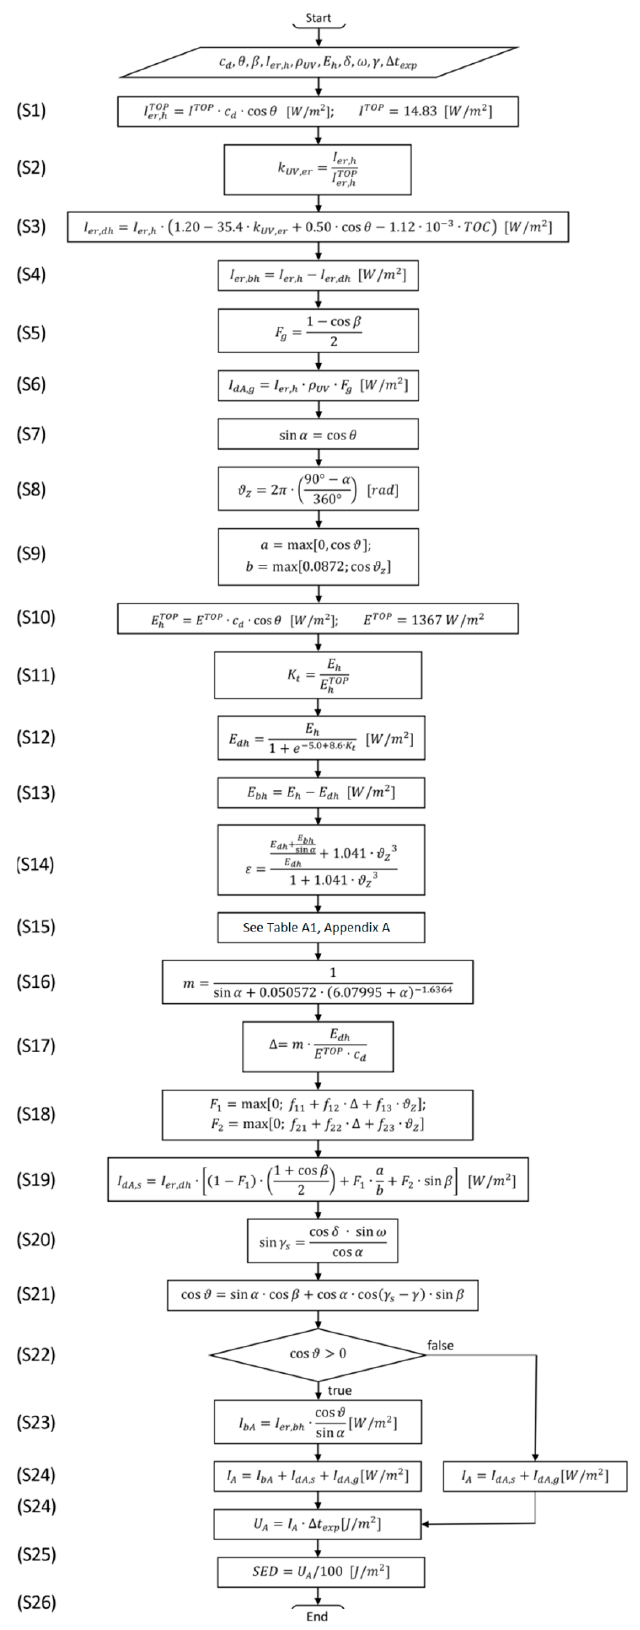
Figure 1. Flow-chart representation of the developed algorithm (the steps are sequentially numbered; for a complete list of used symbols, see Table A2 in Appendix A).